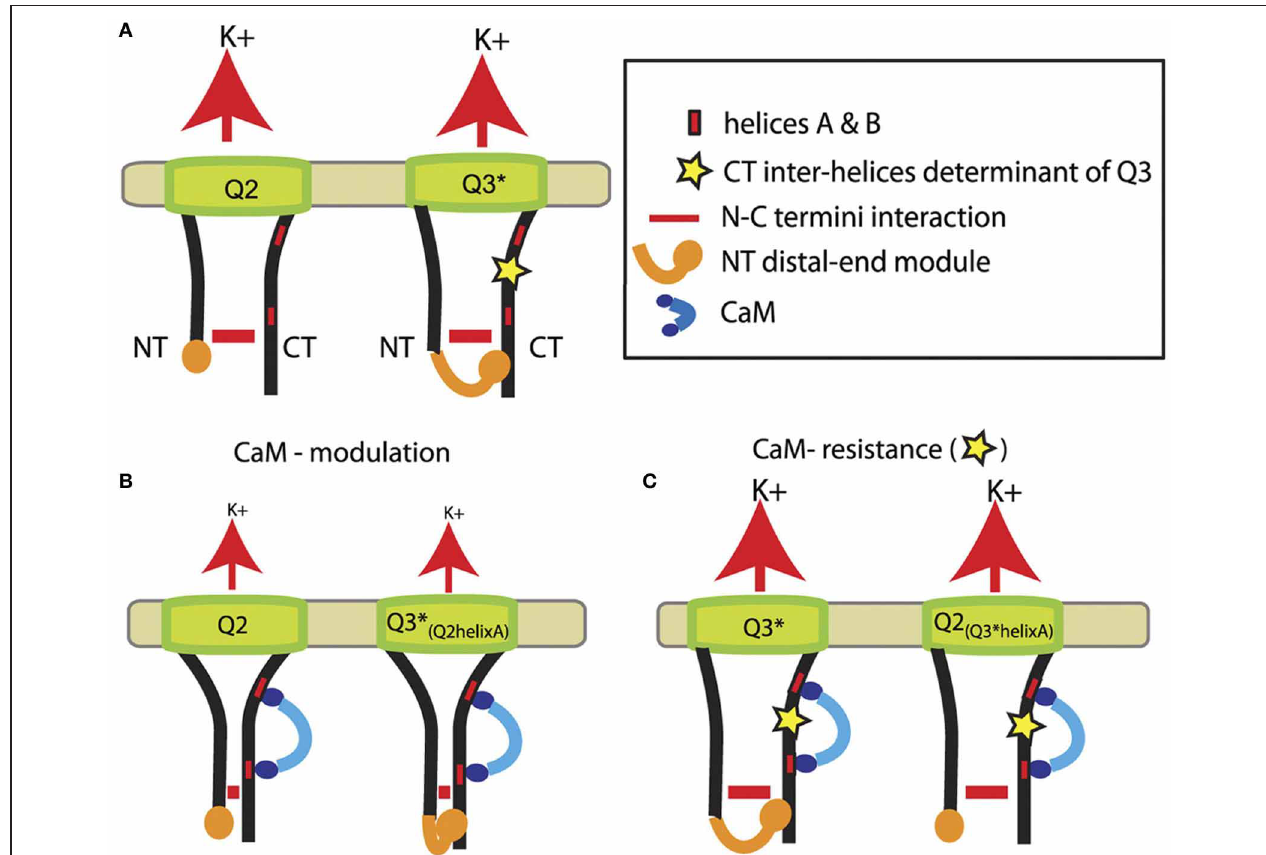
FIGURE 2 | Model showing the role of N-C terminus interaction in the regulation of KCNQ2-3 channels by CaM. (A) Representation of KCNQ2 and KCNQ3 mutant (A315T) channels (helices C and D in the C-terminus were omitted for clarity) with the N-C terminus interaction (horizontal red lines) and the additional interaction between the distal end of the N-terminus and the